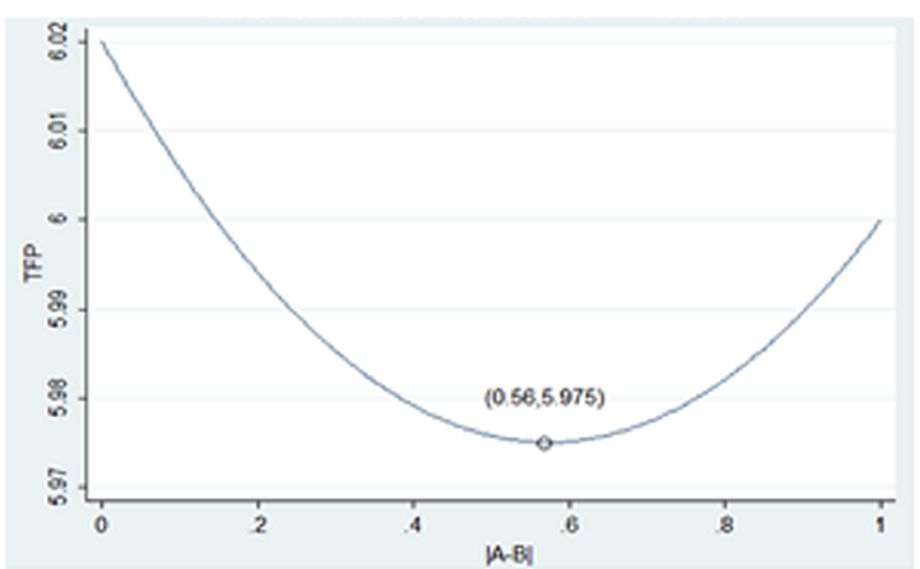
Fig 1. The relationship between heterogeneous ownership balance degree and the efficiency of mixed ownership